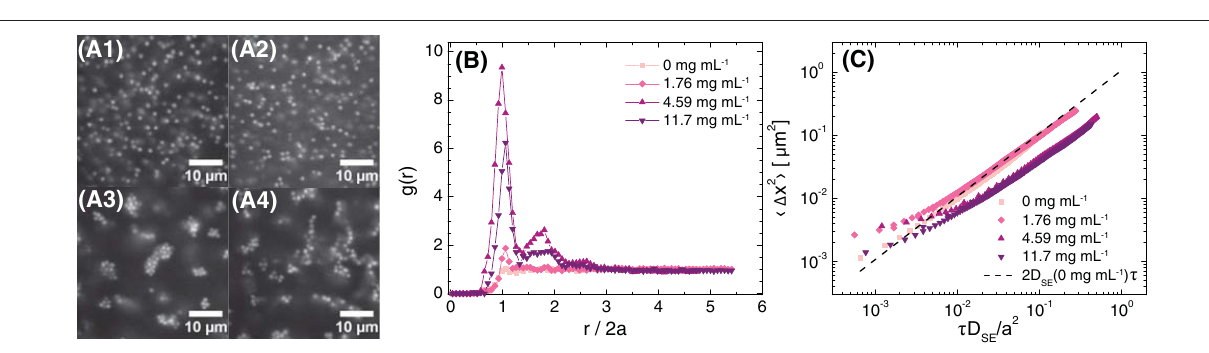
FIGURE 5 | (A) Confocal micrographs at z = 30 µ m (brightness/contrast adjusted), (B) radial distribution function as a function of normalized distance from the particle center, and (C) 1-dimensional mean-squared displacement as a function of non-dimensionalized delay time τ D SE / a 2 for φ = 0.05 suspensions in 80 (w/w)% glycerol in water, 21 ± 2 mM NaCl, and various concentrations of polyacrylamide in the free volume. The polyacrylamide concentrations in the free volume are (A1) 0 mg mL − 1 , (A2) 1.76 mg mL − 1 , (A3) 4.59 mg mL − 1 , and (A4) 11.7 mg mL − 1 . The dashed line in (C) is the MSD calculated for Stokes-Einstein diffusion in 80 (w/w)% glycerol in water with 20 mM